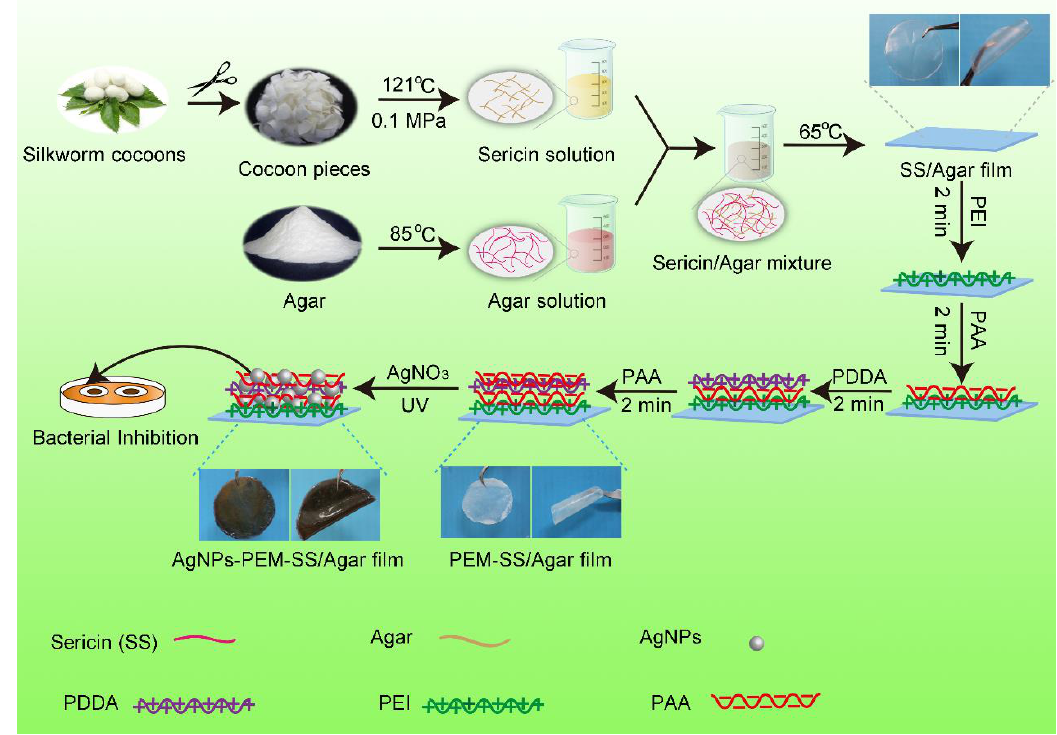
Figure 1. Preparation and antibacterial analysis of AgNPs ‐ PEM ‐ SS/Agar film.